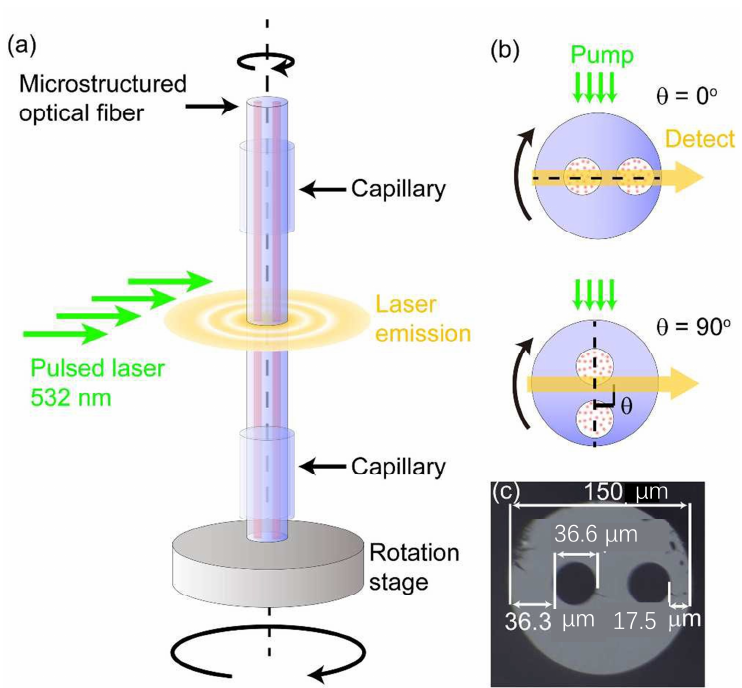
Figure 8. Dual-hole microstructure fiber-based microcavity laser. ( a ) Schematic diagram of the experimental setup; ( b ) Schematic cross-sectional view; and ( c ) Cross-sectional electron microscope image [59].